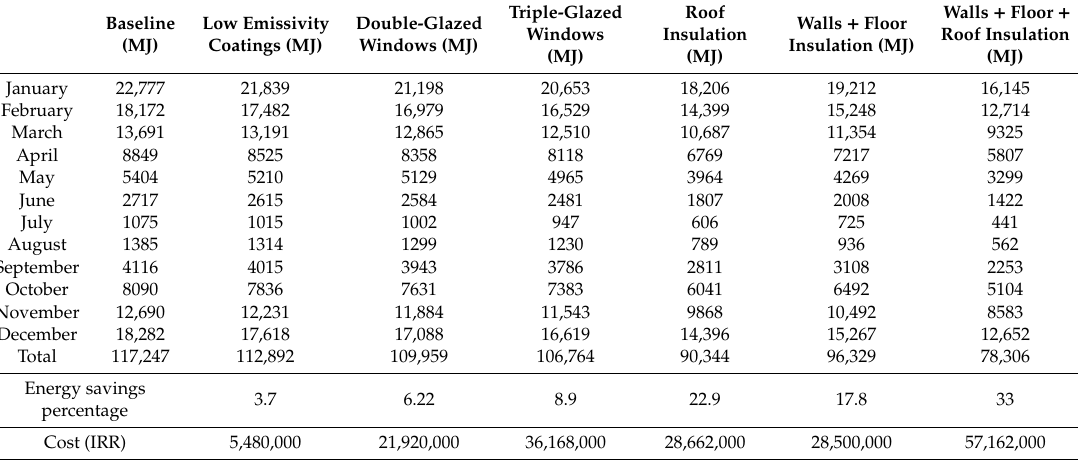
Table 6. Energy conservation scenarios in the envelope and